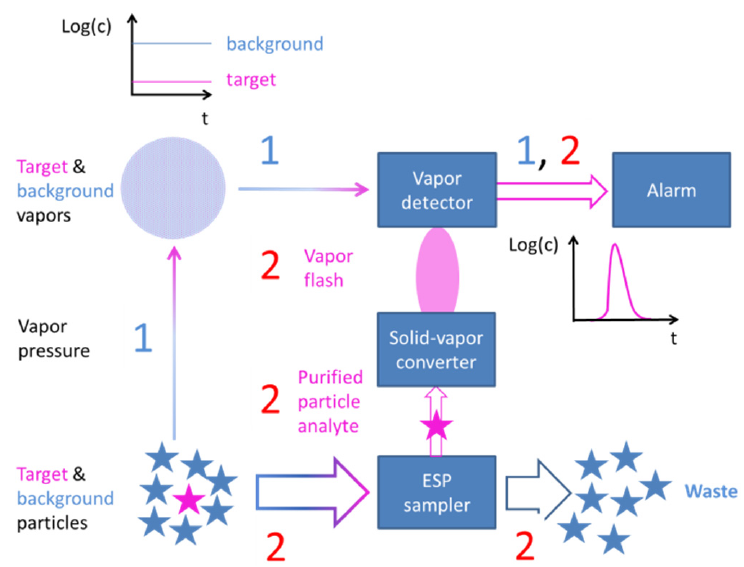
Figure 24. Detecting explosives and illicit drugs with the help of solid ‐ state gas sensors. In Process Sequence 1, the small amounts of vapors emerging from the particle residue in the lower left corner are directly detected using a solid ‐ state gas sensor. In Process Sequence 2, the solid particle residue is collected, purified, flash ‐ evaporated and vapor ‐ detected.